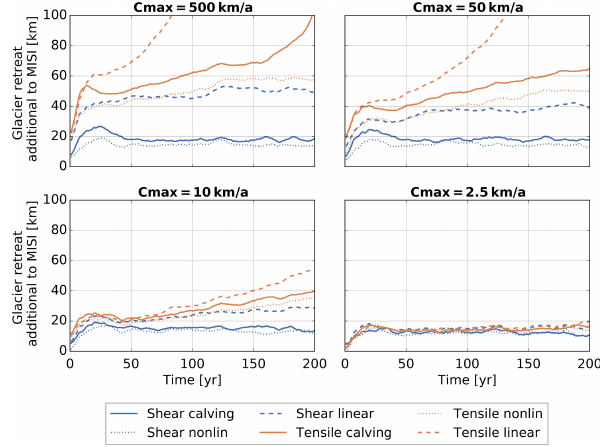
Figure 8. Time series of glacier retreat in addition to the MISI re- treat, i.e. retreat caused by